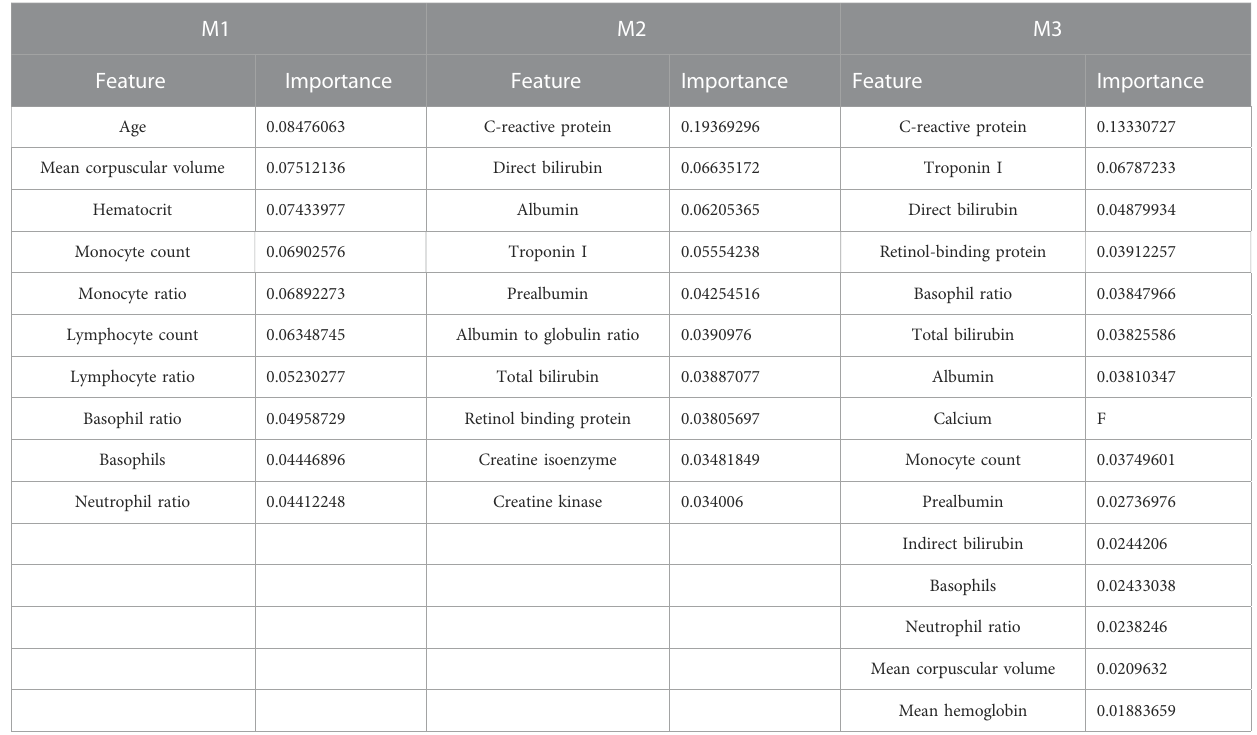
TABLE 3 Characteristic importance ranking of M1, M2, and M3